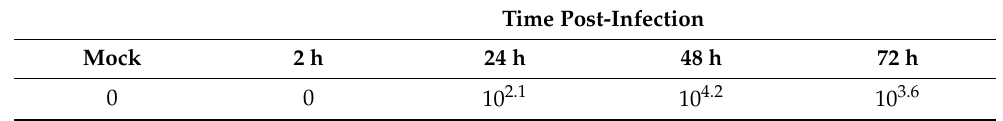
Table 2. Viral titer of the supernatant of the placenta tissue culture, using the method of TCID